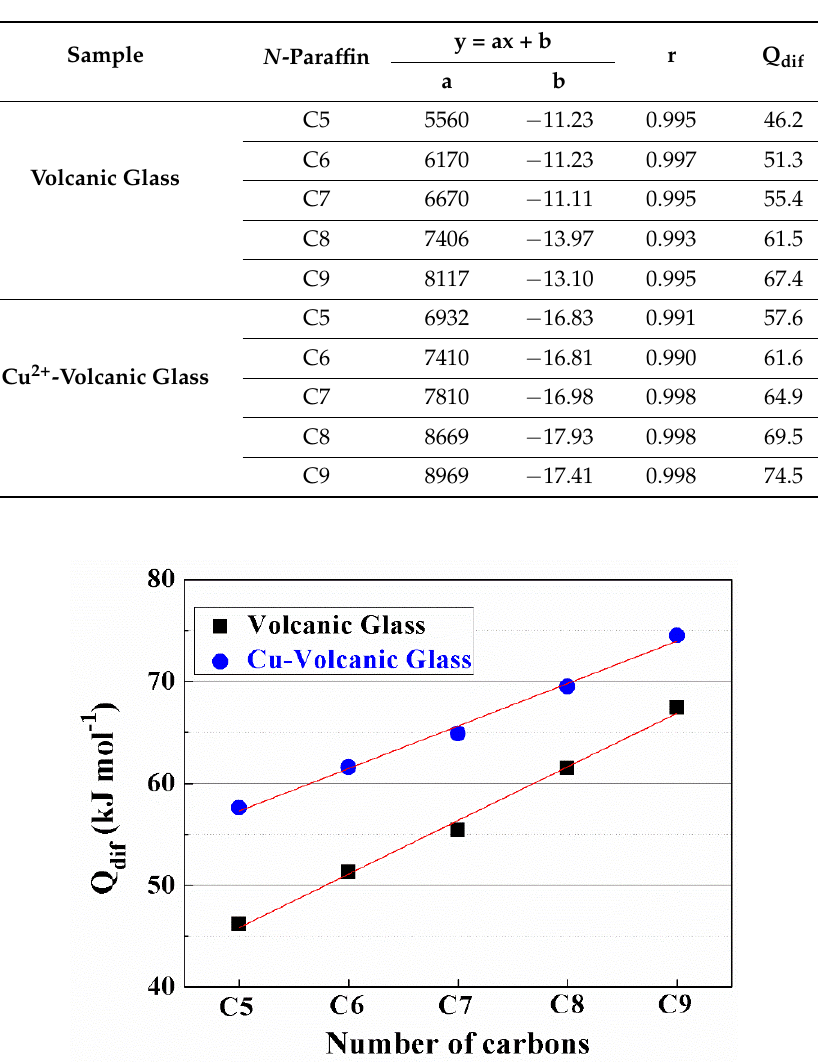
Table 4. Fitting parameters of the adsorption isotherms of C 5 –C 9 on volcanic glass and Cu 2+ -volcanic glass at 273 K.